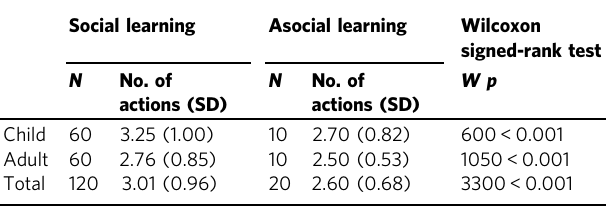
Table 3 Summary of the interactive logistic regression model for